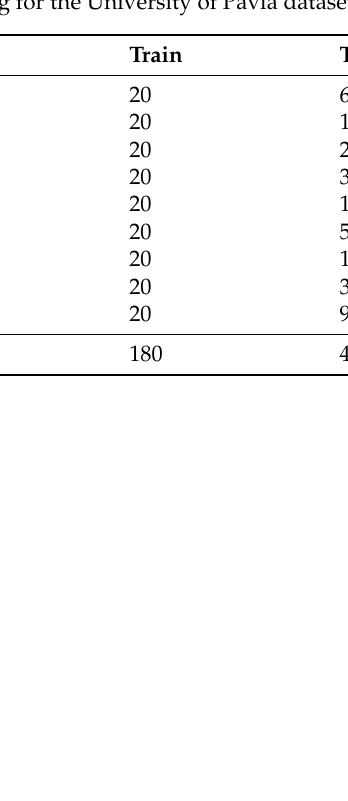
Table 1. The numbers of the training and testing sampling for the University of Pavia dataset.